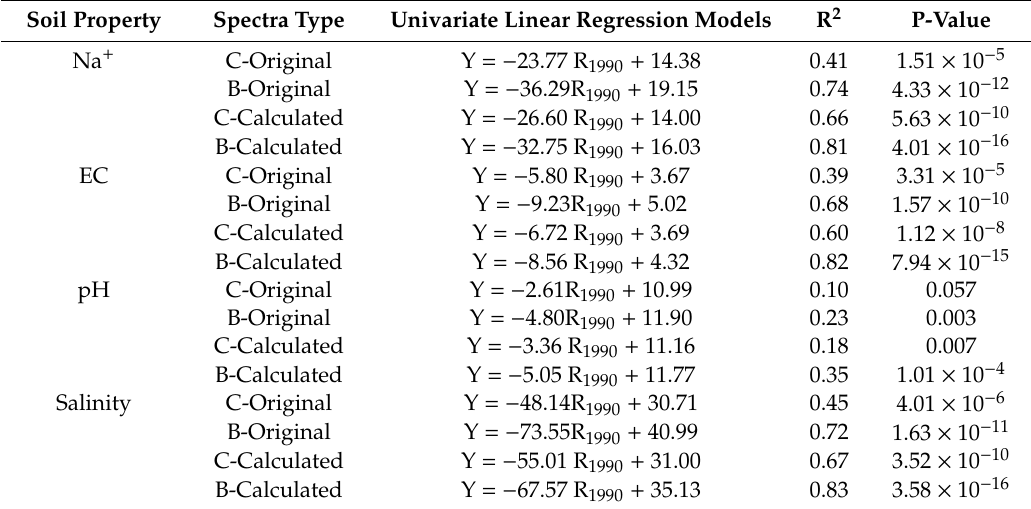
Table 2. Univariatelinear regression models for soil properties of soil